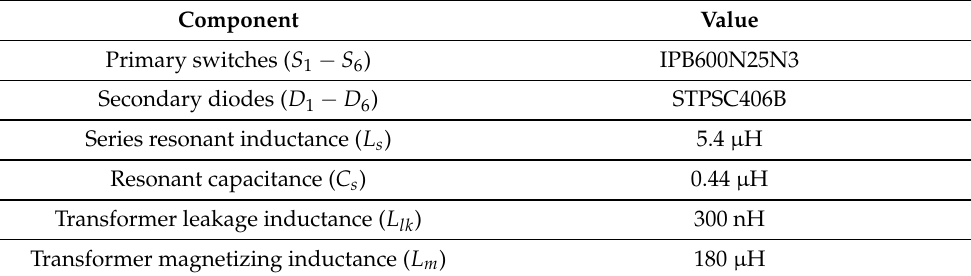
Figure 17. Waveforms at 80 V input and full load condition ( a ) Experimental voltage across switch S 2 ( v ds 2 (50 V/div)) and primary current i pr 1 (5 A/div) ( b ) Simulated voltage ( v ds 2 (50 V/div)) and current i pr 1 (5 A/div) from PSIM ( c ) Experimental primary currents i pr 1 , i pr 2 and i pr 3 (5 A/div) ( d ) Zero voltage switching at turn-on of switch S 2 ( v gs 2 -10V/div, v ds 2 -50 V/div, i pr 1 -5 A/div). Table 4. Component